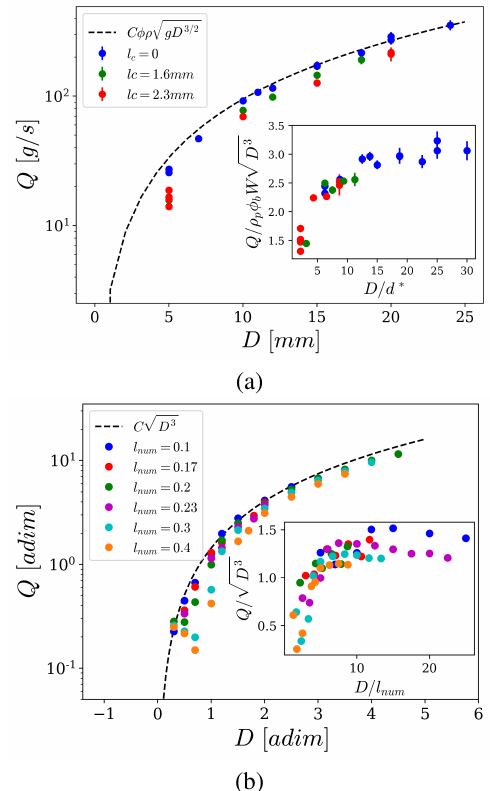
Figure 6. (a) Mass flow rate as a function of D for several cohe- sion. Inset : Normalised mass flow rate as a function of D / d ∗ . (b) Numerical mass flow rate as a function of D . Inset : normalised numerical mass flow rate as a function of D / l c